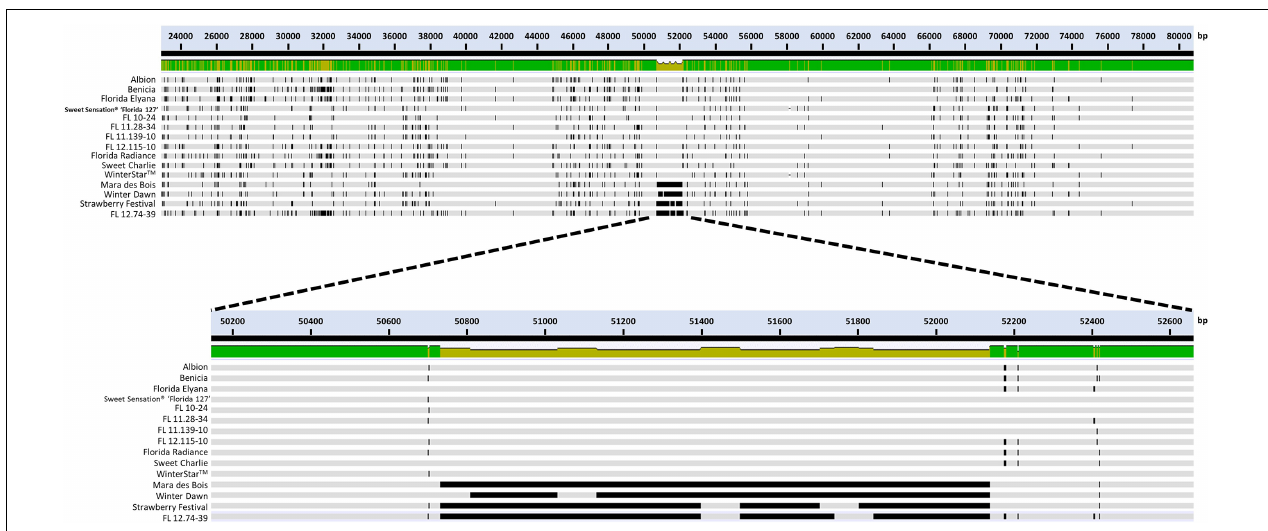
FIGURE 3 | Hybrid-probe captured sequencing for the 100-kb flanking region of FaFAD1 and comparative analysis among γ -D producers and γ -D non-producers. Illumina short reads (150 bp PE) were assembled to the FvFAD1 region from the F. vesca reference genome (Edger et al., 2018). Each line represents a 100-kb flanking region of FaFAD1 for 15 genotypes. The dark black lines represent deleted genomic sequences in the FaFAD1 region.